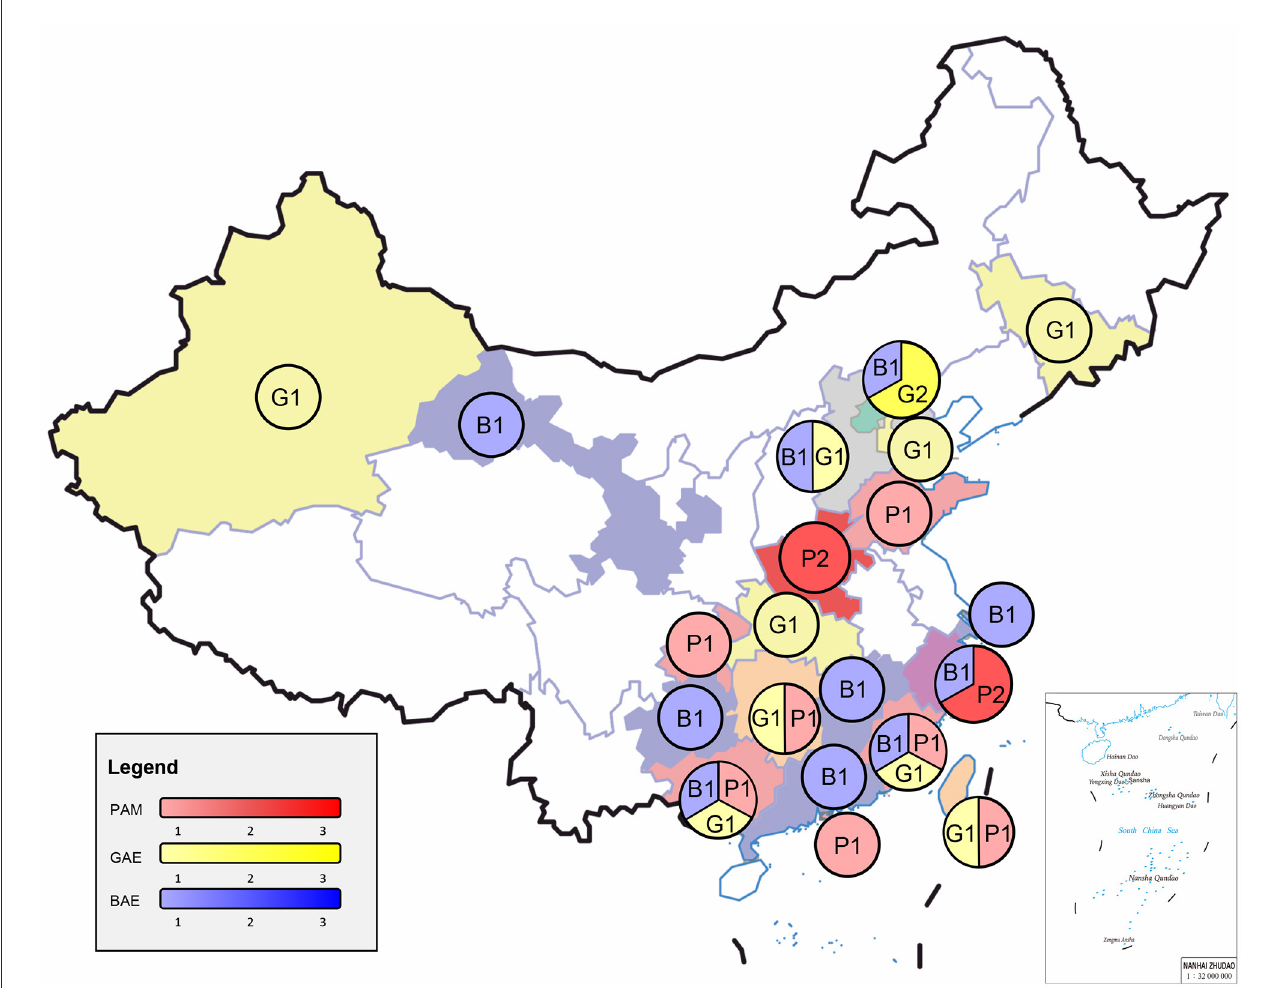
FIGURE1 Epidemiology and clinical cases of three free-living amoebae infections in China. PAM, primary amoebic meningoencephalitis; GAE, granulomatous amoebic encephalitis; BAE, balamuthia amoebic